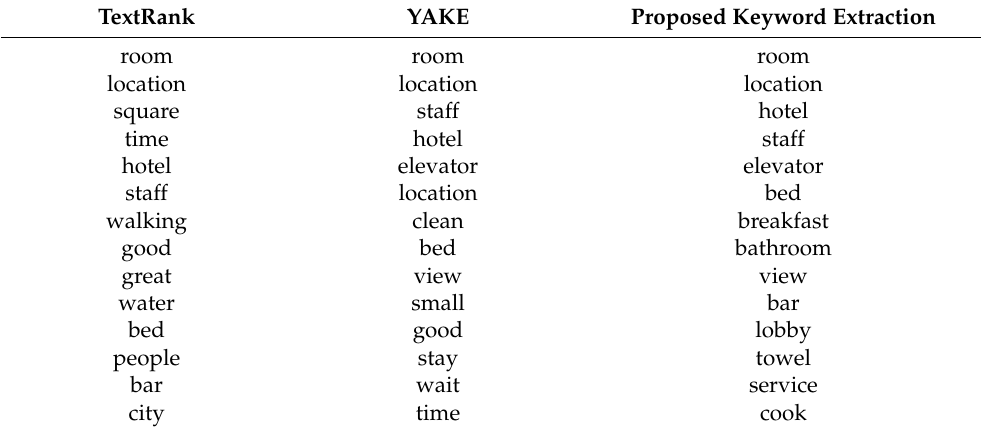
Table 5. Comparison of different keyword detection methods.